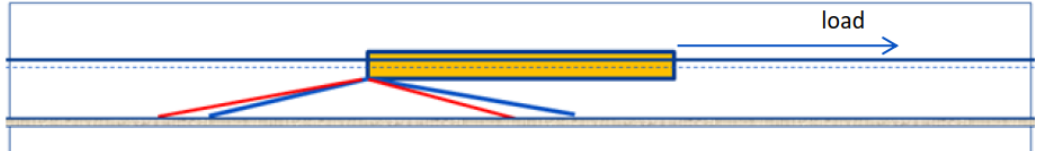
Figure 10. Experimental setup used to define load extension characteristics of the mooring system.